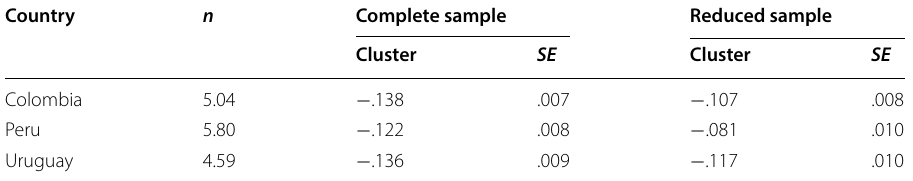
Table 6 The average number (n) of not-reached items and comparison of position effects in PISA 2012 mathematics between the complete sample and the reduced sample with students with not-reached item responses excluded in three selected countries Country n Complete sample Reduced sample Cluster SE Cluster